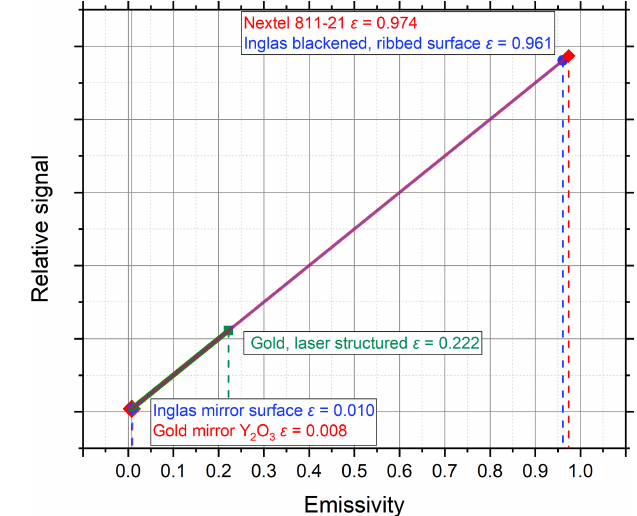
Figure 9. The calibration of the TIR 100-2 with the three calibra- tion sets given in Table 3. The dependence of the relative sensor signal on the emissivity of the reference sample is shown.